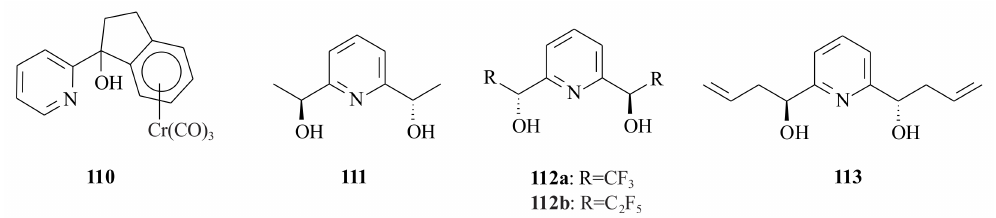
Figure 22. Cr complex and pyridinyl diols used in addition reactions of aldehydes.